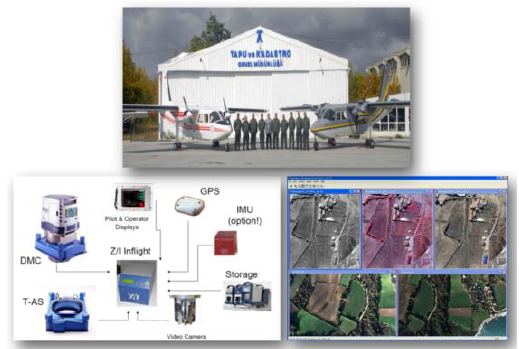
Figure 7. Aerial photo taking staff and equipment